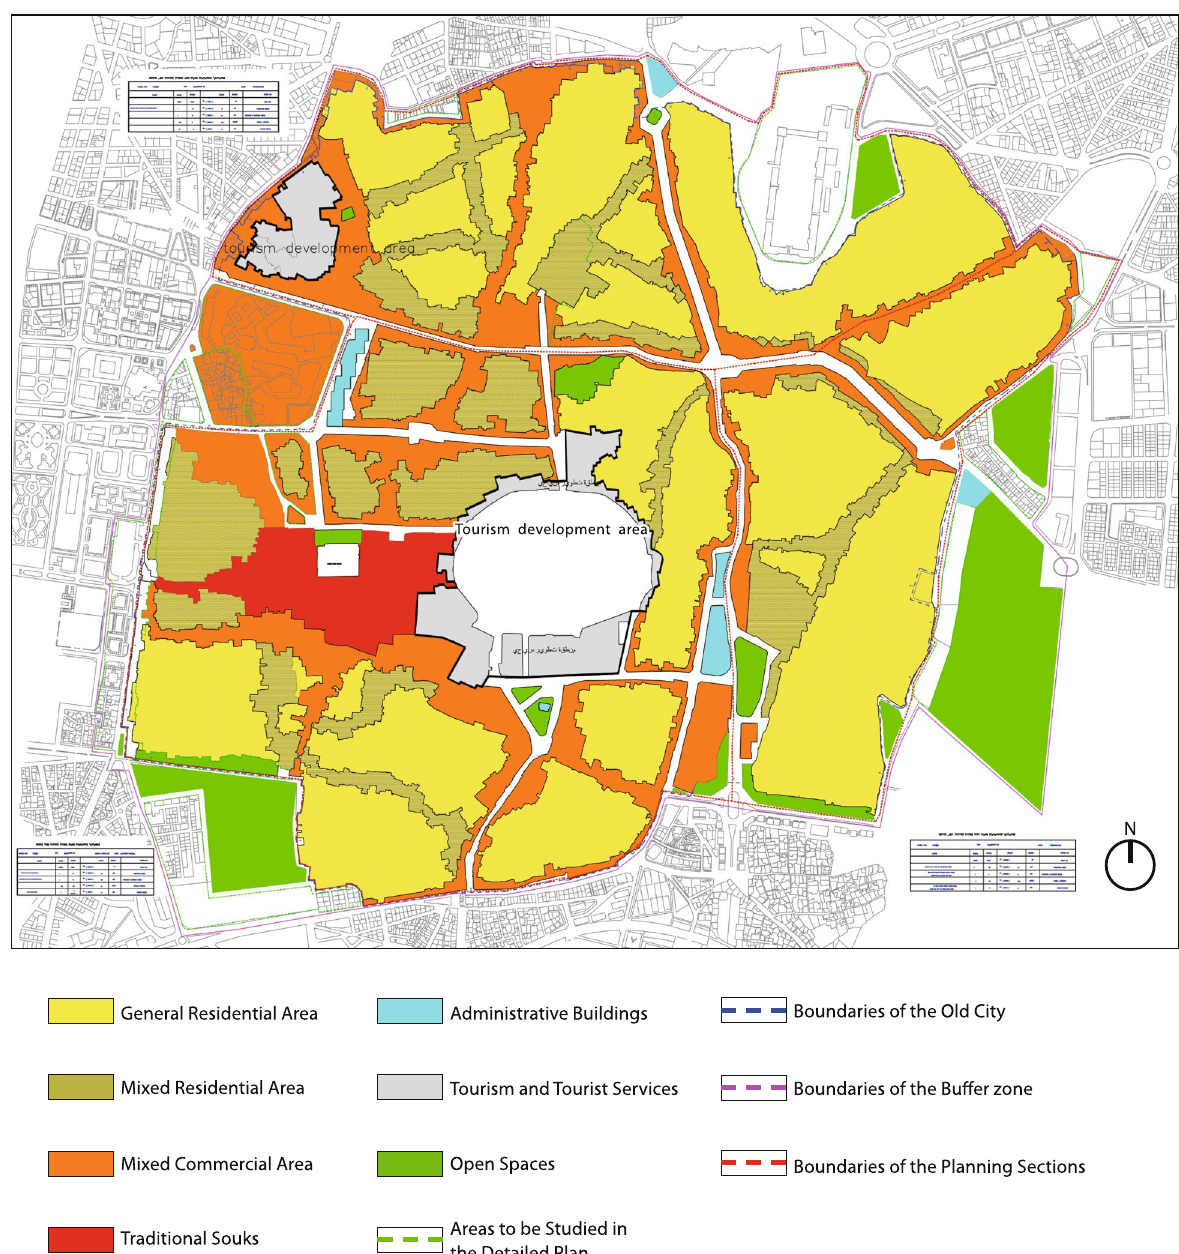
Fig. 8 ‘Proposed Land Use Map of The Old City’ from the ‘Development Plan’ of the Old City of Aleppo Proposed by the GTZ and DOCA (Source: GTZ and DOCA